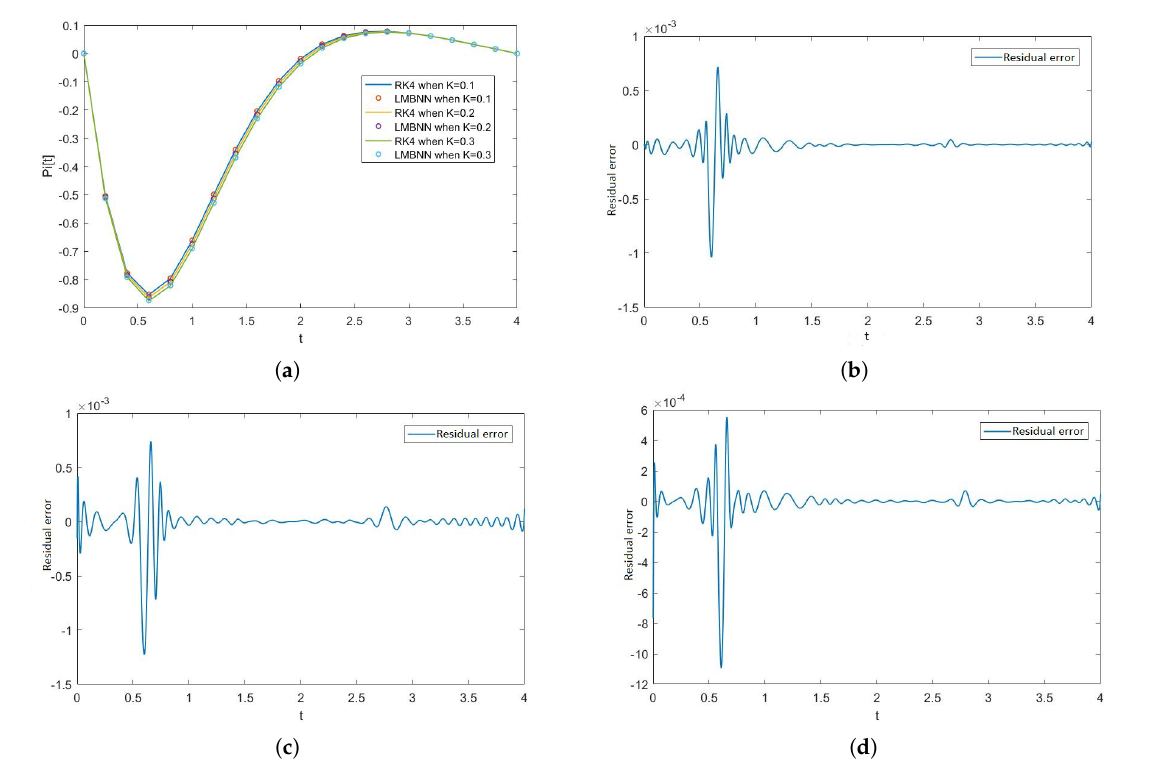
Figure 8. Effect of rotation parameter K on Φ and the graphs of error in numerical outputs of RK4 and LMBNN. ( a ) Numerical solutions of Φ when K varies. ( b ) Error in Φ when K = 0.1. ( c ) Error in Φ when K = 0.2. ( d ) Error in Φ when K =